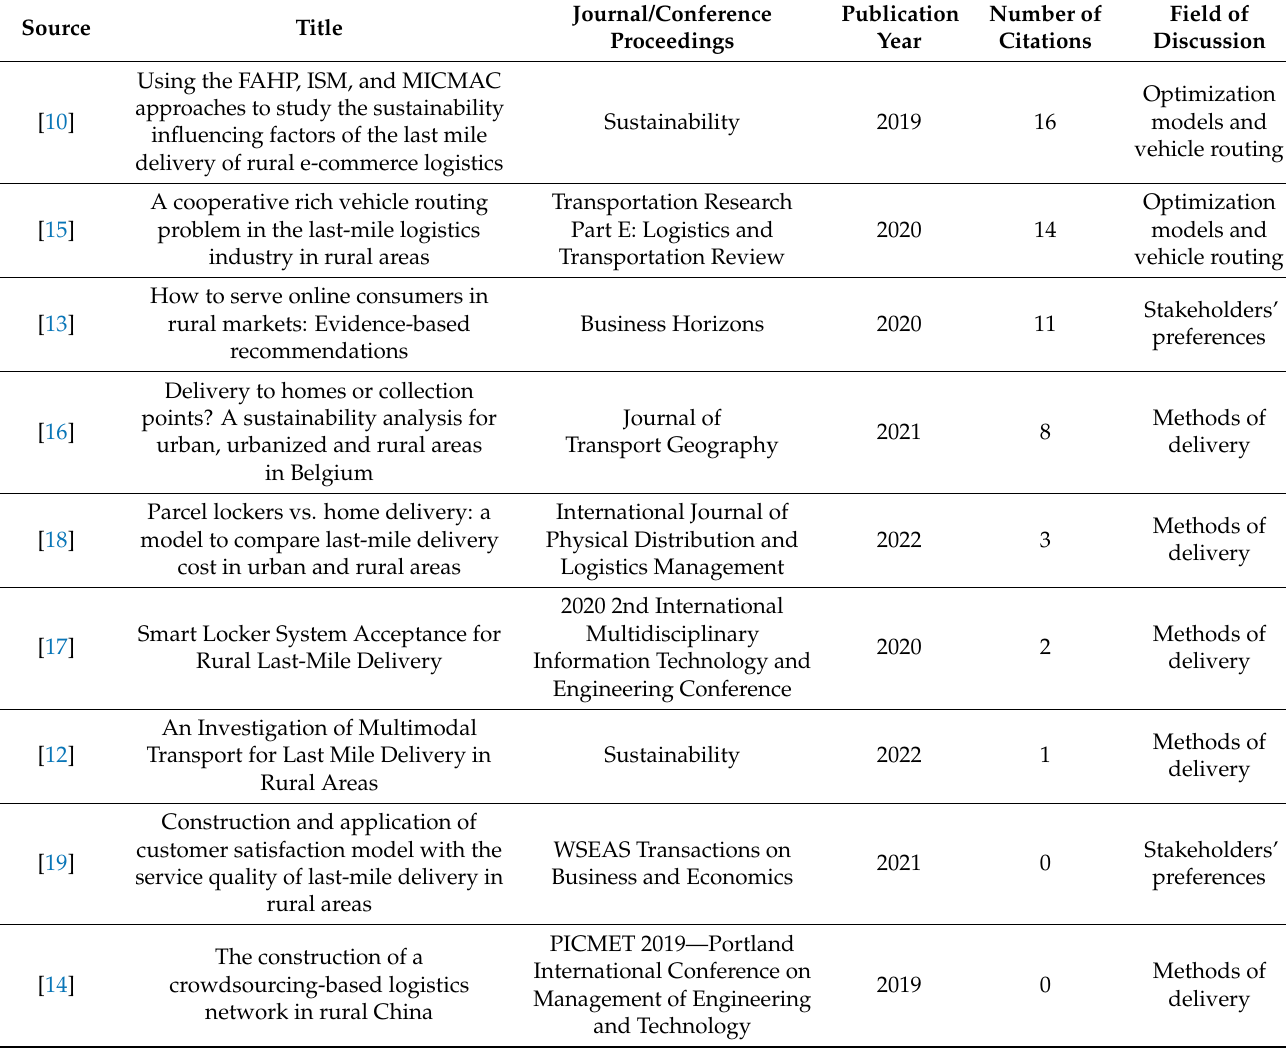
Table 1. Papers on last mile delivery in rural areas in Scopus database (own